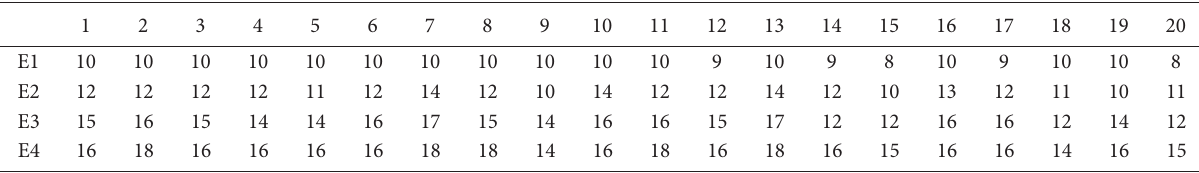
Table 2. Number of leaflets up to the fourth eophyll in Aeschynomene evenia .